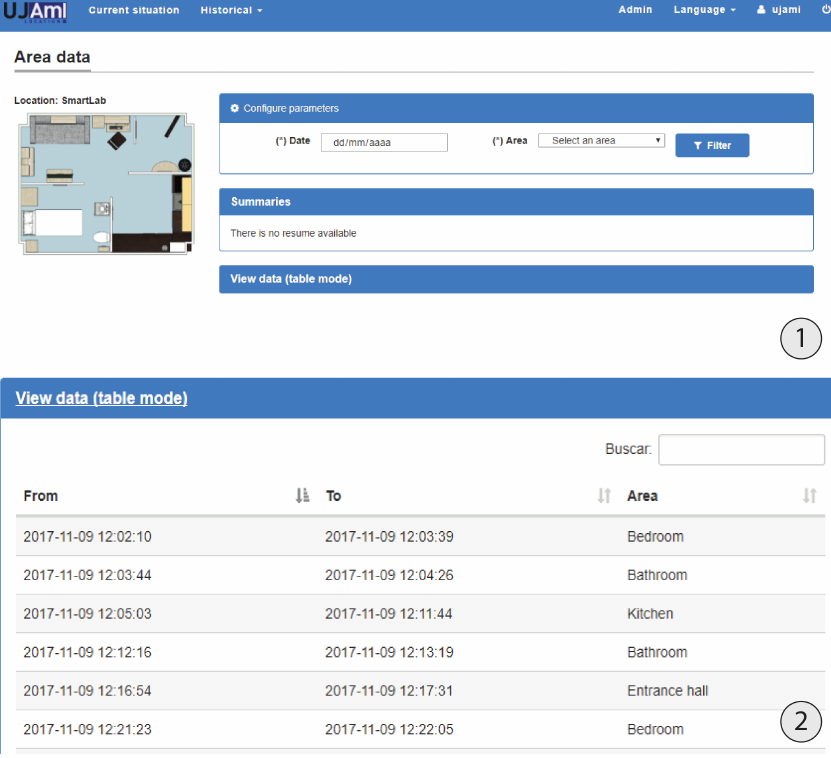
Figure 13. ( 1 ) Real-time tracking and ( 2 ) information about inhabitant